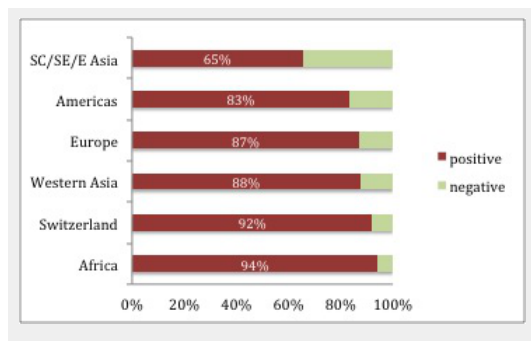
Varicella seropositivity according to nationality in travellers seeking pre-travel advice at the Travel Clinic of the University of Zurich between December 2008 and August 2015 who had an uncertain or negative varicella history (n = 1749). SC = South Central; SE = South-East; E = East; Europe = European countries except Switzerland; χ 2 test p